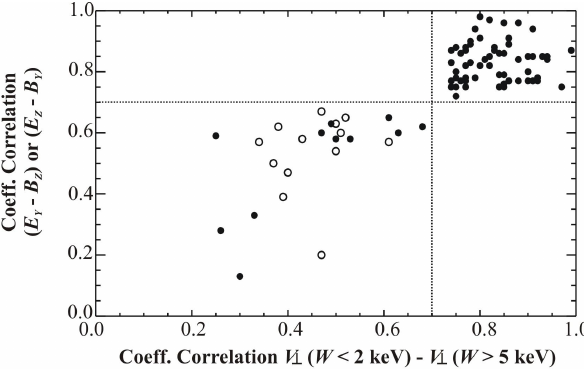
Fig. 7. Scatterplot of the coefficients of correlation between the per- pendicular velocities of low-energy (below 2keV) and high-energy ( > 5keV) ion components observed in each PSBL crossing (when high velocity field-aligned ions were registered) versus the coeffi- cients of the best correlation between electric and magnetic field variations: either between δEY 0 and δBZ 0 or between δEZ 0 and δBY 0 detected in a particular crossing. The PSBL crossings, where the density of low-energy ions was < 0.01cm − 3 , are shown by empty